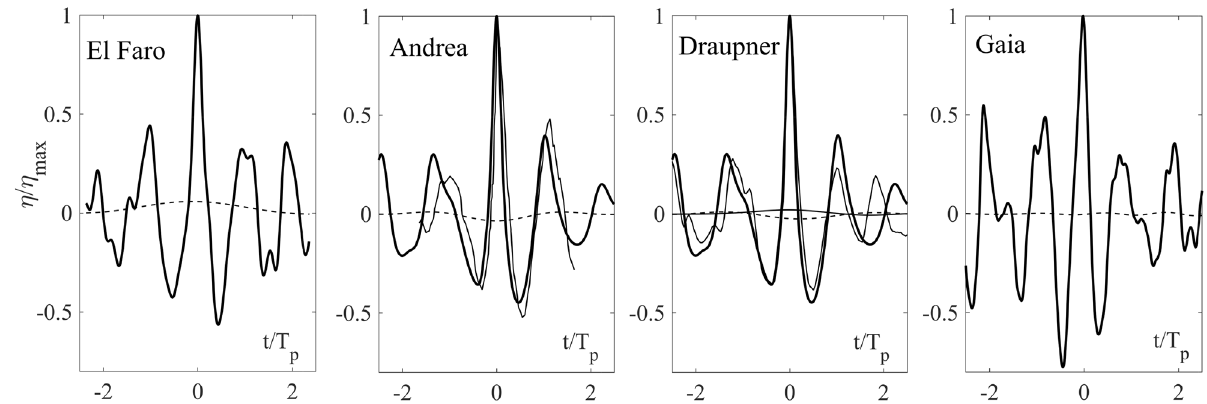
h > ξ H s for crest heights, and [ ]